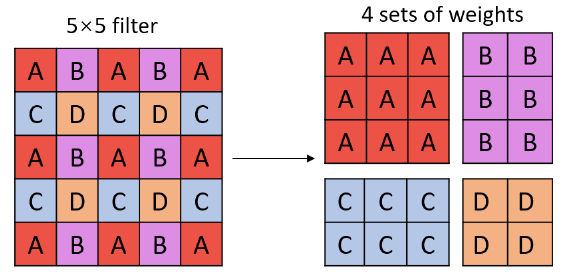
Figure 3. Fast-up convolution concept.